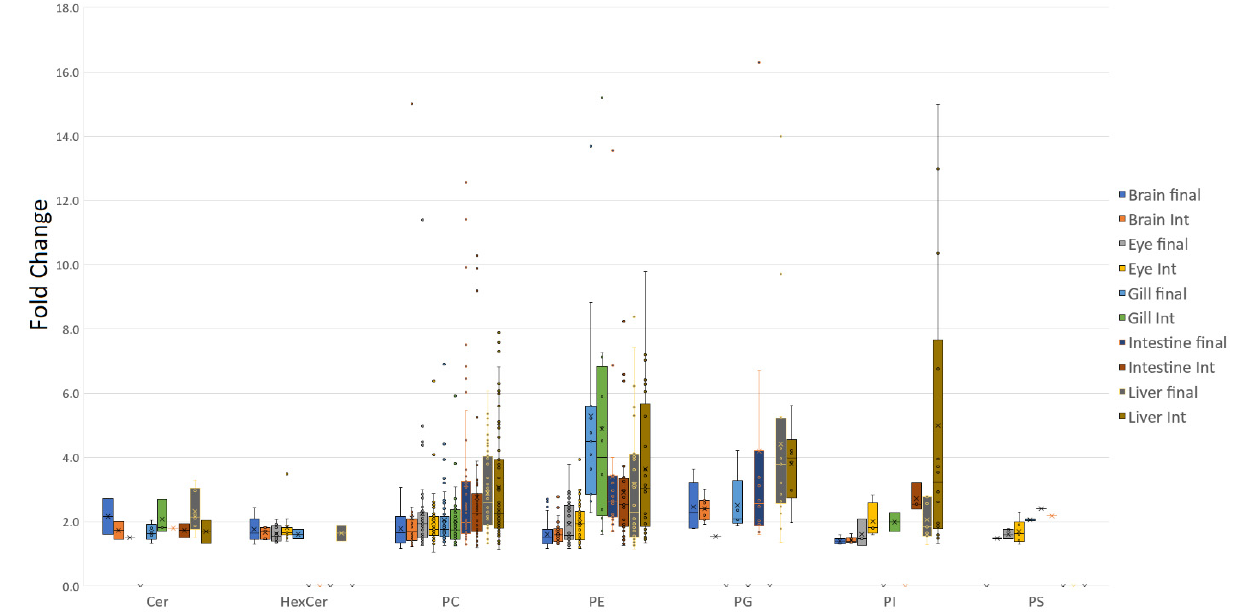
Figure 1. Phospholipid class fold distribution for untargeted QTOF data. The average fold distribution of lipids determined to be significant showed that, in general, the brain and eye exhibited smaller fold changes across the majority of lipid classes. The liver, however, generally exhibited the greatest variance in lipid alteration in response to diet.